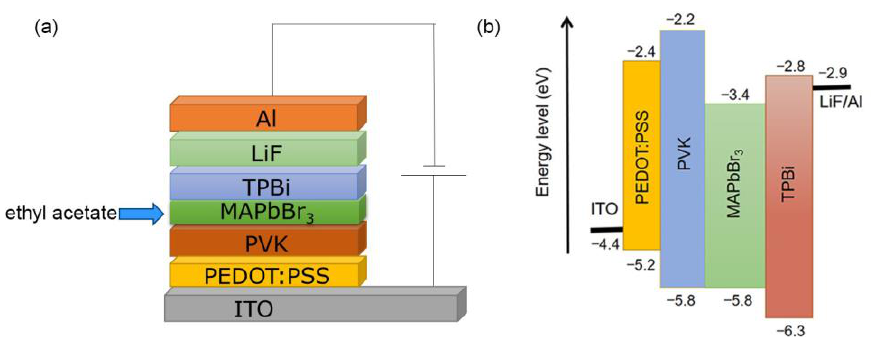
Figure 4. ( a ) S tructure and energy ( b ) level diagram of the PeLED